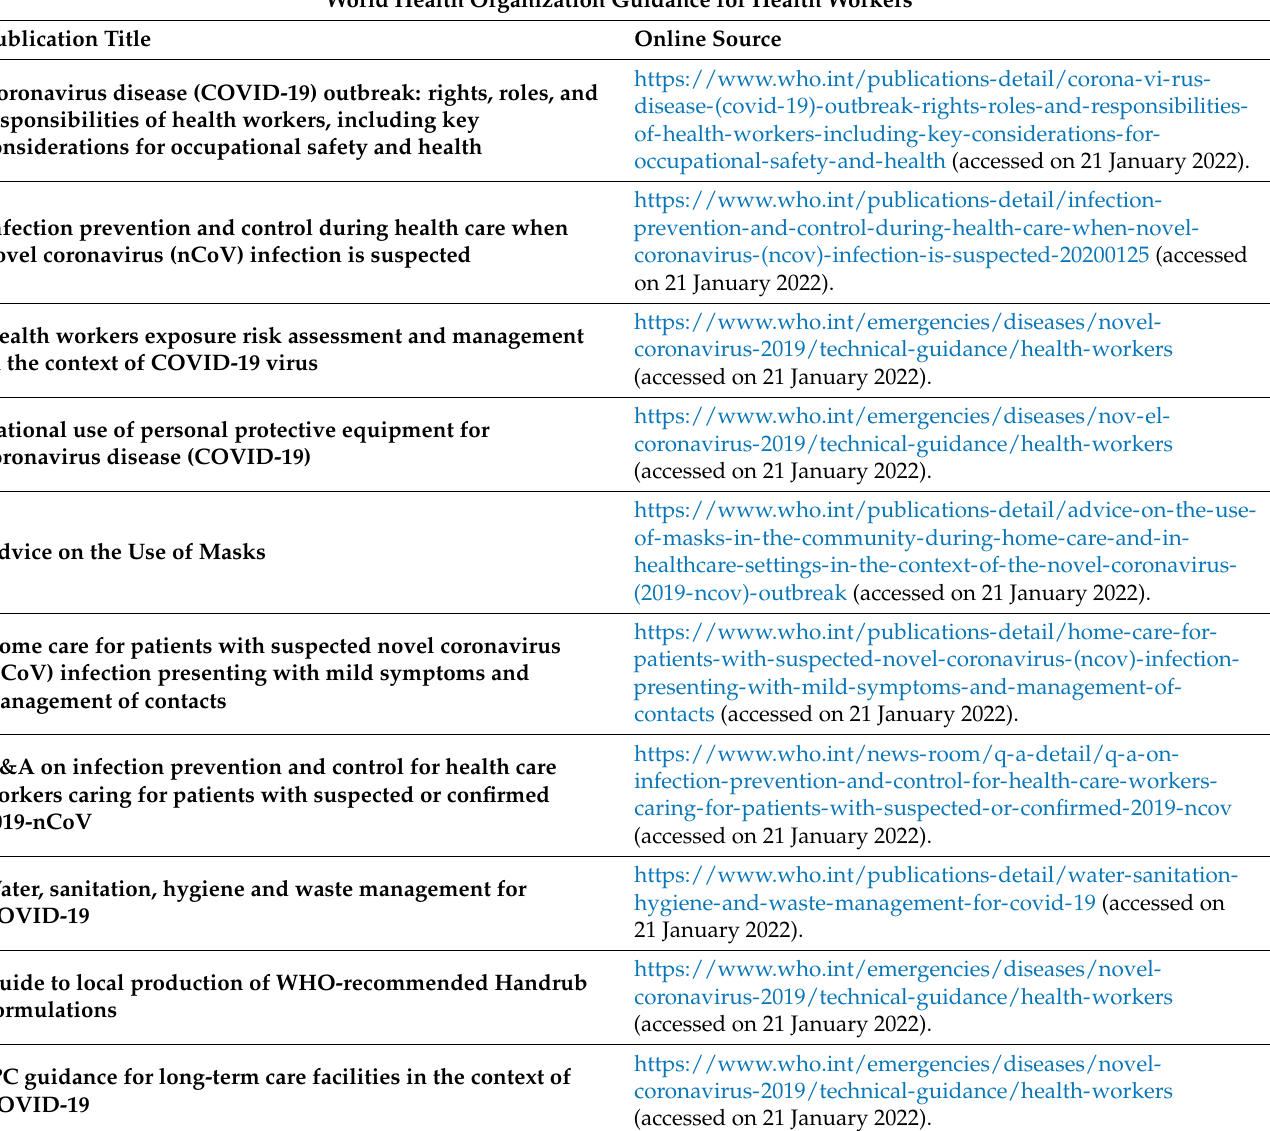
Table 1. Guidance for health workers. List of the publications by World Health Organization. World Health Organization Guidance for Health